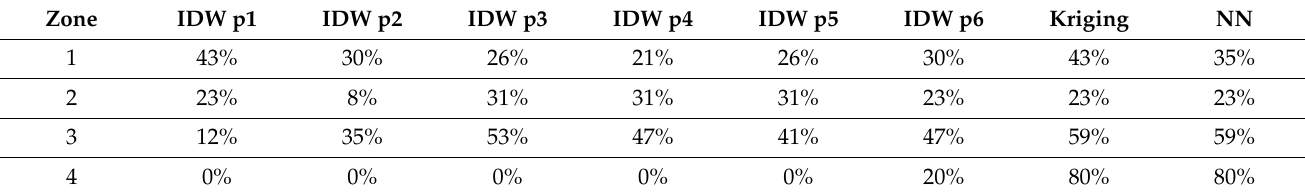
Table 7. The comparison of CEPs in zones for selected interpolation methods and lowest RMSE